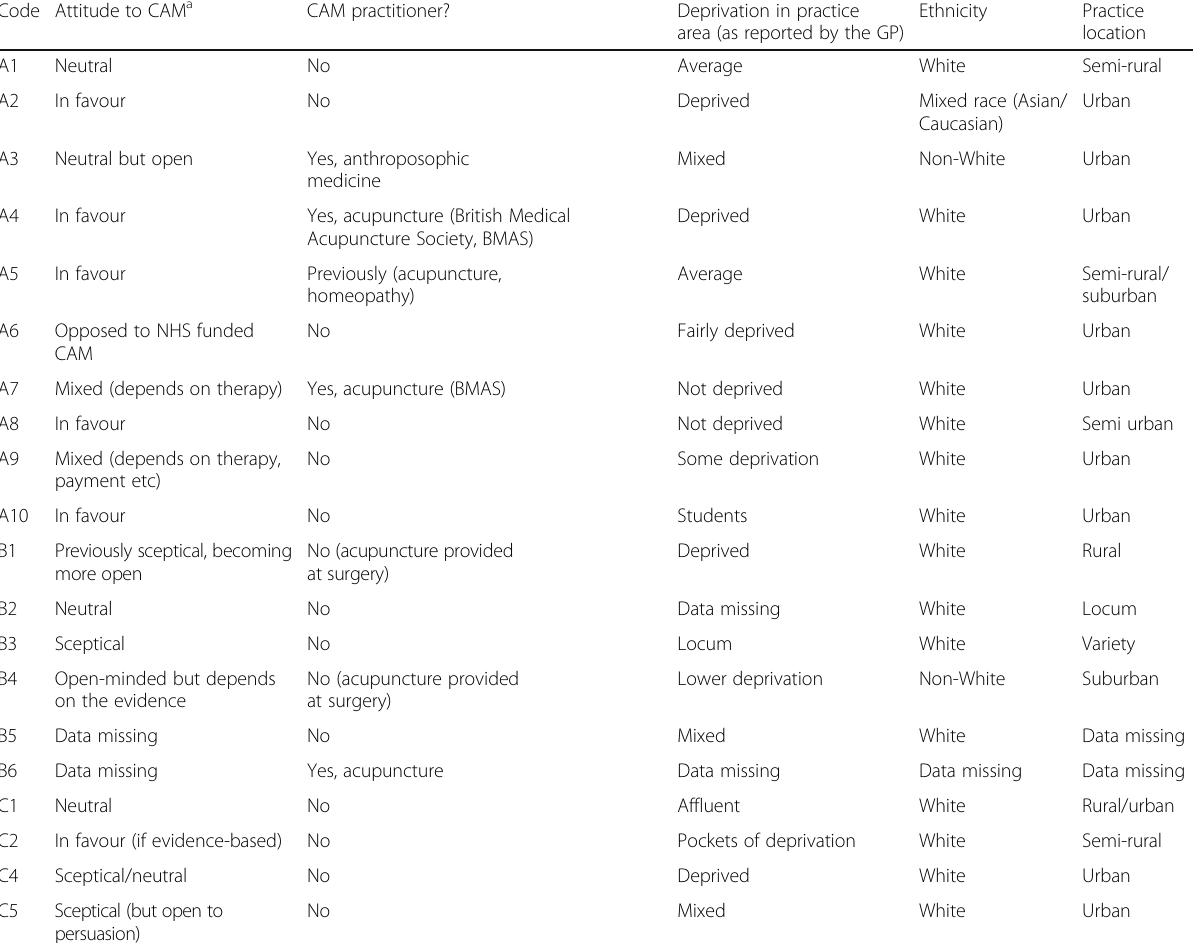
Table 2 Participants in GP focus